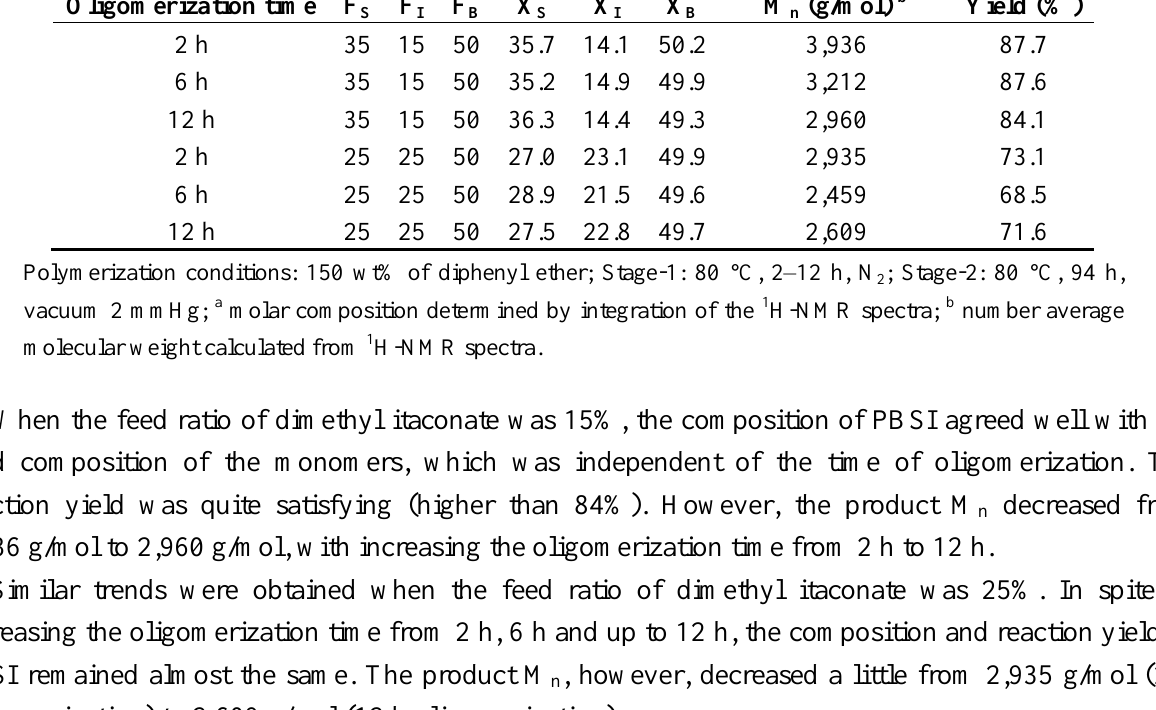
Table 2. The effect of oligomerization time on CALB-catalyzed synthesis of PBSI. Molar composition Feed (%) PBSI a (%) Molecular